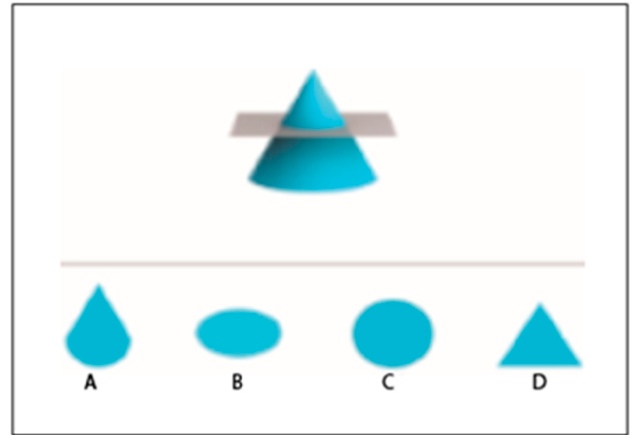
Figure 2. The Santa Barbara Solids Test contains four options in different forms, namely A, B, C or D, of which the correct answer is the one representing the part sectioned by the level cutting